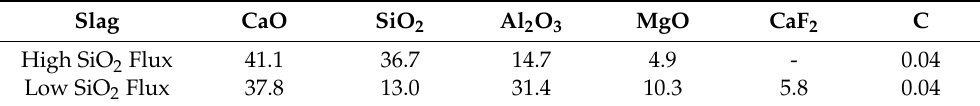
Table 1. Components of mold flux